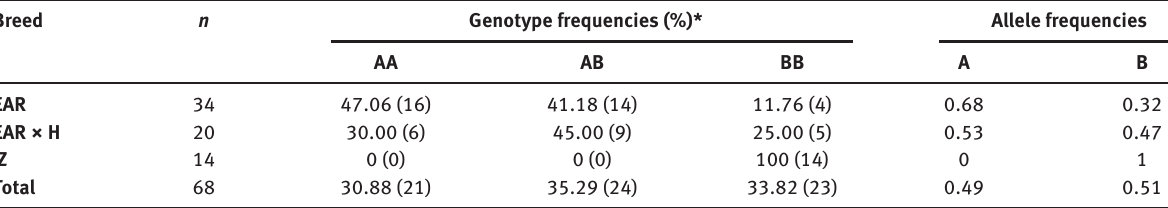
Table 1: Genotype and allele frequencies of the SNP of the bovine FSHB gene Breed n